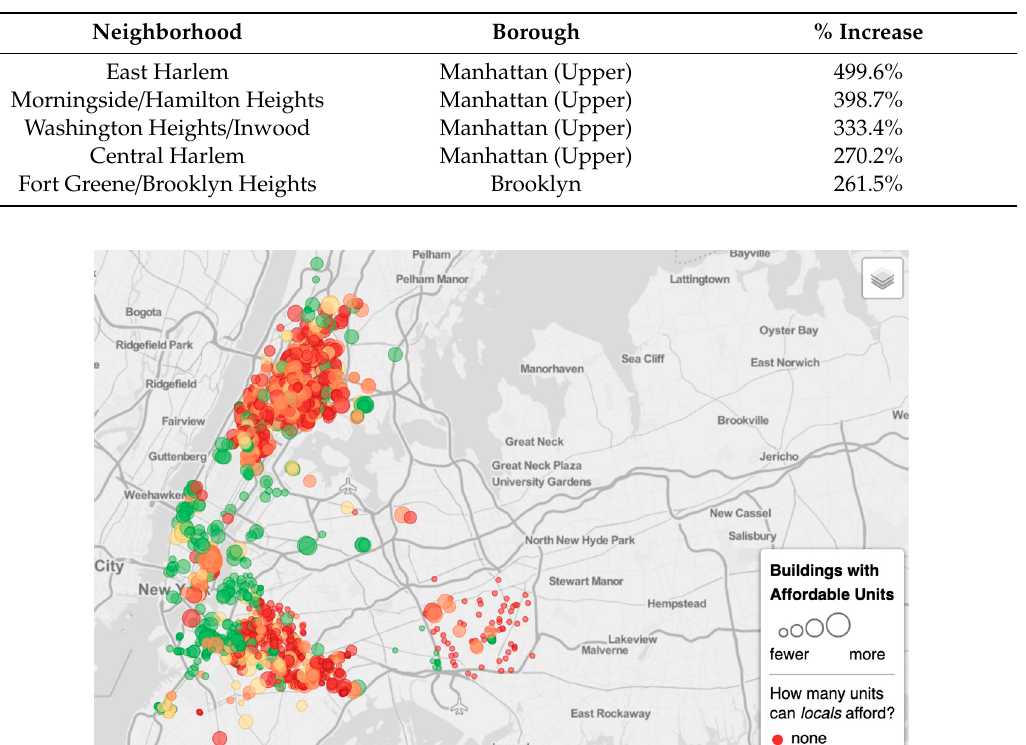
Table 2. Neighborhoods with the largest increases in home sale prices (1996–2006).